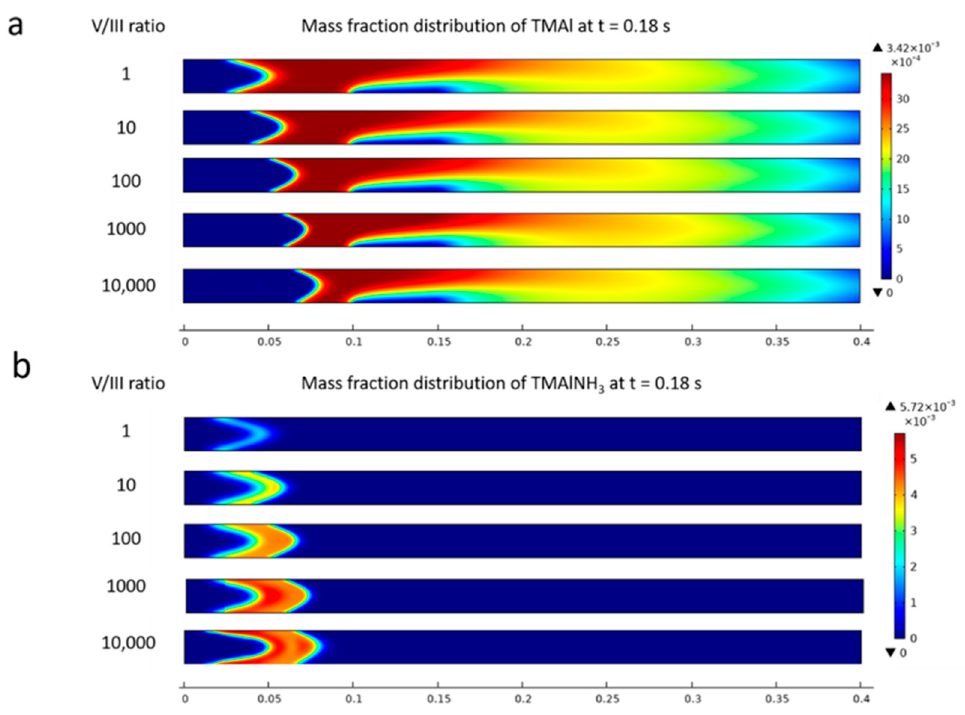
Figure 4. Mass fraction distributions of ( a ) TMAl and ( b ) TMAlNH 3 at 0.18 s for different V/III ratios.